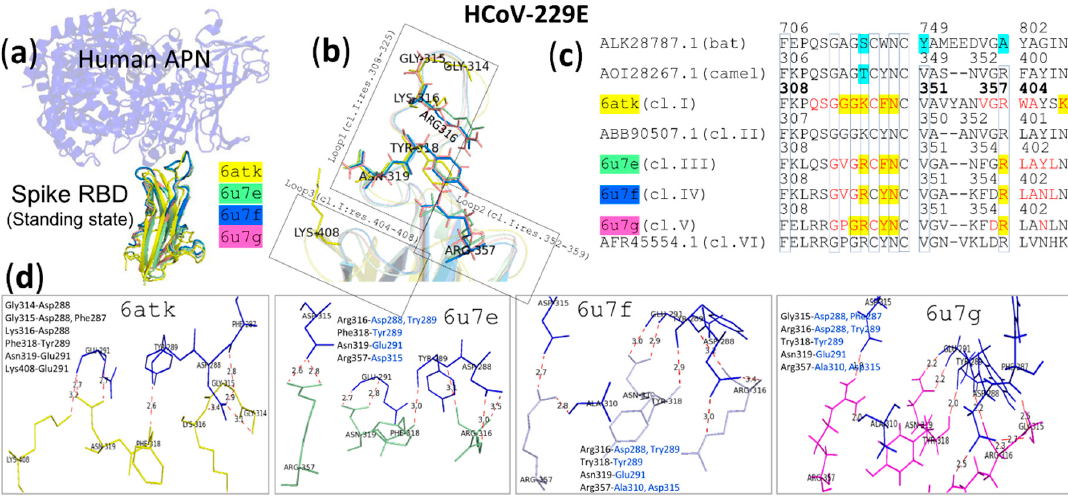
Figure 7. Comparison of receptor binding sites of six classes of S1-CTD RBDs of HCoV-229E variants. ( a ) Superimposition of pdb-available four classes (pdb: 6atk-class I (yellow), 6u7e-class III (pale green), 6u7f-class IV (marine) and 6u7e-class V (salmon)) of the S1-CTD RBDs of HCoV-229E variants in complex with human APN (transparent blue). ( b ) Positions of important aa residues in receptor binding sites (RBSs) of the four classes of the S1-CTD RBDs that have direct interactions with human APN. ( c ) Alignment of aa sequences of six classes of the S1-CTD RBDs. Residues in the S1-CTD RBDs facing the human APN receptor, called RBSs, are shown in red. The residues in RBSs directly interacting with residues in the APN receptor are highlighted in yellow. ( d ) Direct interactions between aa residues in human APN (blue sticks) and aa residues in RBSs of each S1-CTD RBD class. The bond lengths are shown on the dashed lines in angstrom units. 6atk is from [83], and 6u7e, 6u7f and 6u7g are from